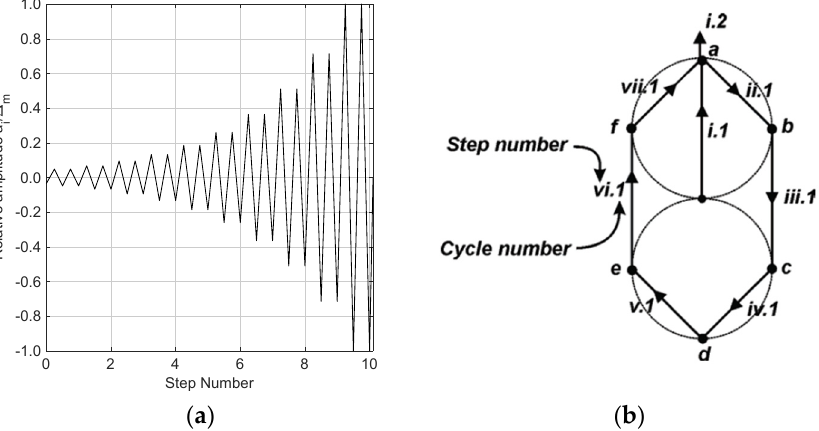
Figure 5. FEMA 461 displacement-controlled quasi-static protocol: ( a ) loading history considering {a n ,a 1 ,n} equal to { ∆ m , 0.0048 ∆ m ,10} and ( b ) displacement orbit for bidirectional loading